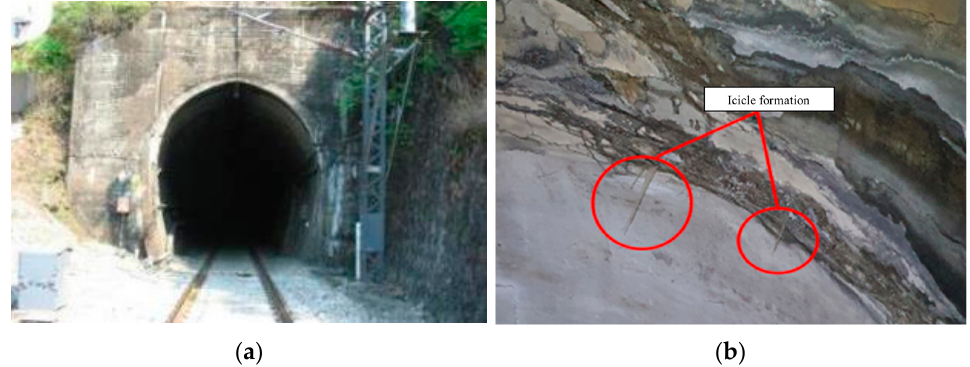
Figure 7. Photographs of Seungbu tunnel: ( a ) the external view of Seungbu tunnel; ( b ) icicle formation in Seungbu tunnel.